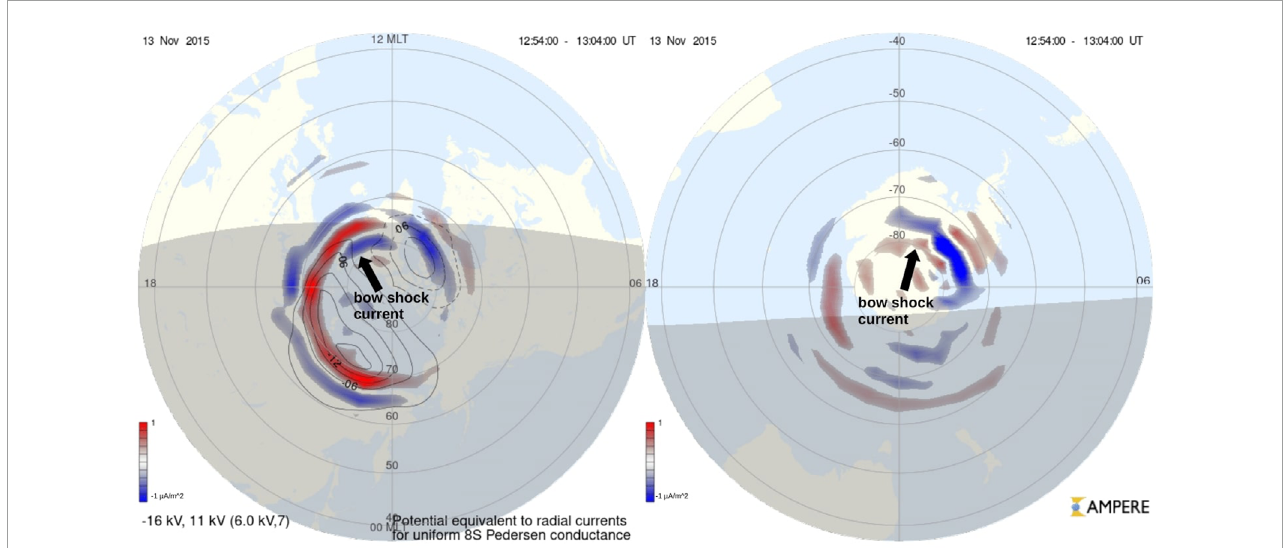
FIGURE 3 AMPERE derived Birkeland currents. The northern hemisphere is on the left and the southern hemisphere is on the right. In both hemispheres, red currents are coming out of the ionosphere and blue currents are going in. The southern hemisphere plot uses a “glass-Earth” projection. We see high latitude unipolar current (indicated) in the afternoon sector in the north and in the morning sector in the south, both with the right polarity to be bow shock current closing into the ionosphere. Potential contours are not available for the southern hemisphere on this day. (Plots from http://ampere.jhuapl.edu/).